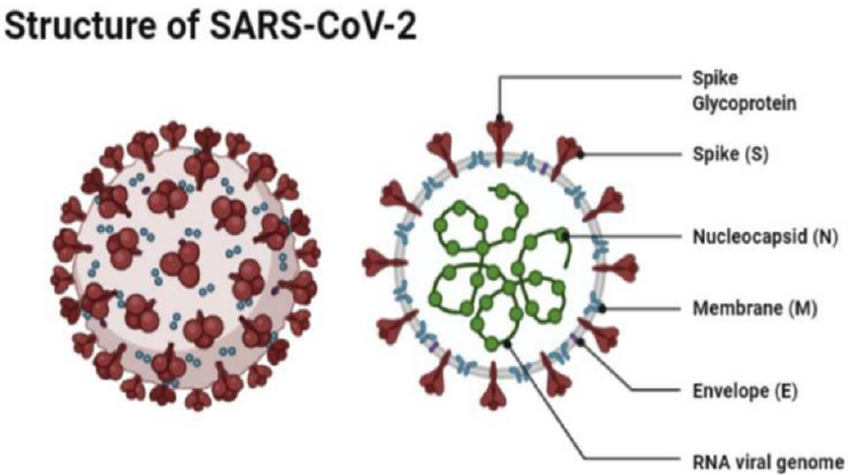
Figure 1. The structure of SAR-CoV-2 under a microscope as illustrated by Agarwal et al. [5]